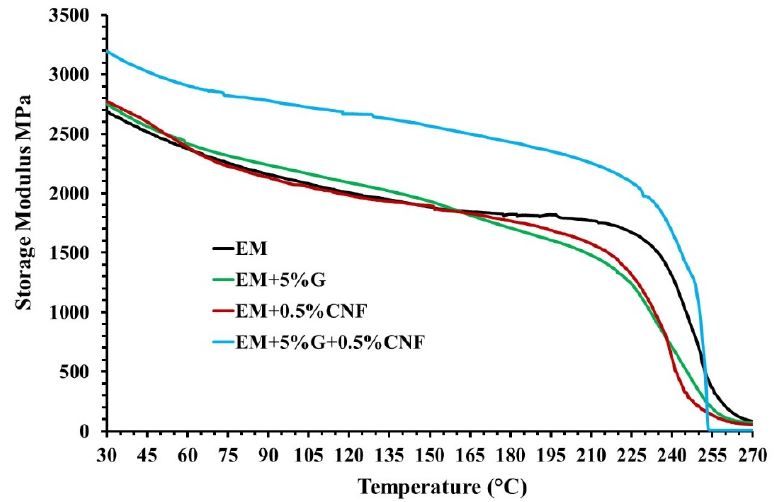
Figure 5. Storage modulus of the epoxy samples isothermally